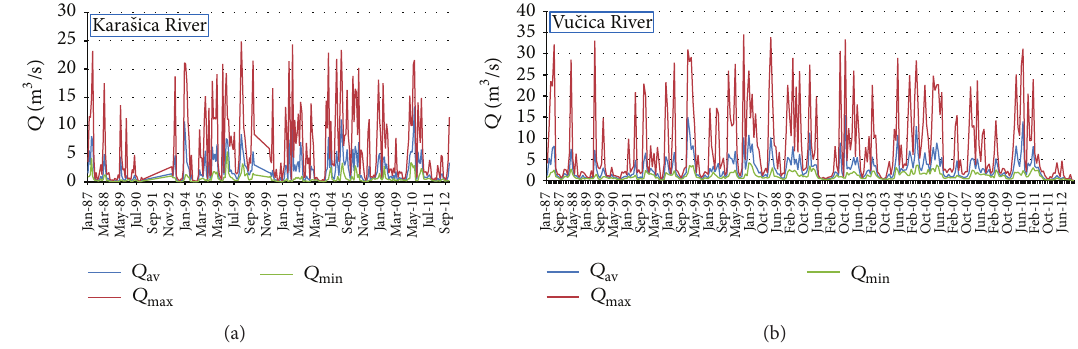
Figure 5: Characteristic discharges of the Karaˇsica River (a) and the Vuˇcica River (b).